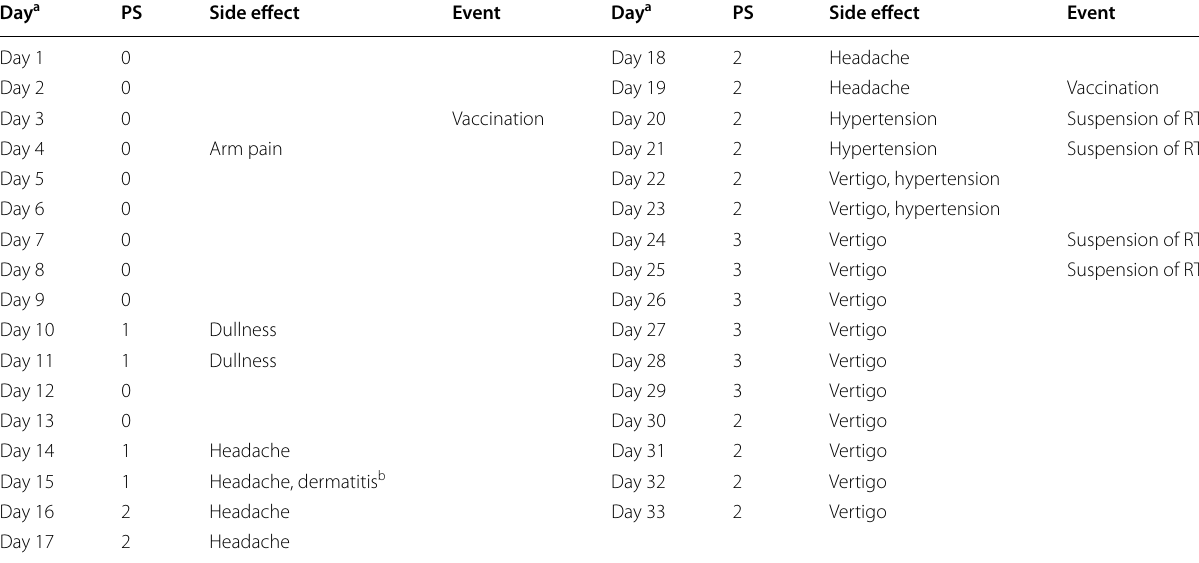
Table 1 Side effects and schedule of radiotherapy and